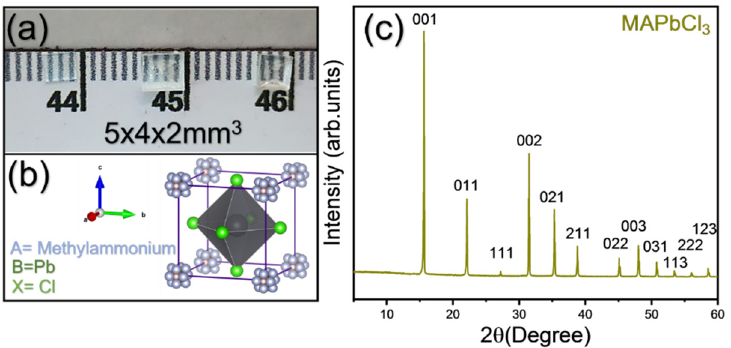
Figure 2. (Color online) A photograph of synthesized single crystals ( a ), a basic unit cell structure and a powder X-ray diffraction pattern of MAPbCl 3 in the cubic phase Pm 3 m ( c ). ( b ), and a powder X ‐ ray diffraction pattern of MAPbCl 3 in the cubic phase 𝑃𝑚3𝑚 ( c ).